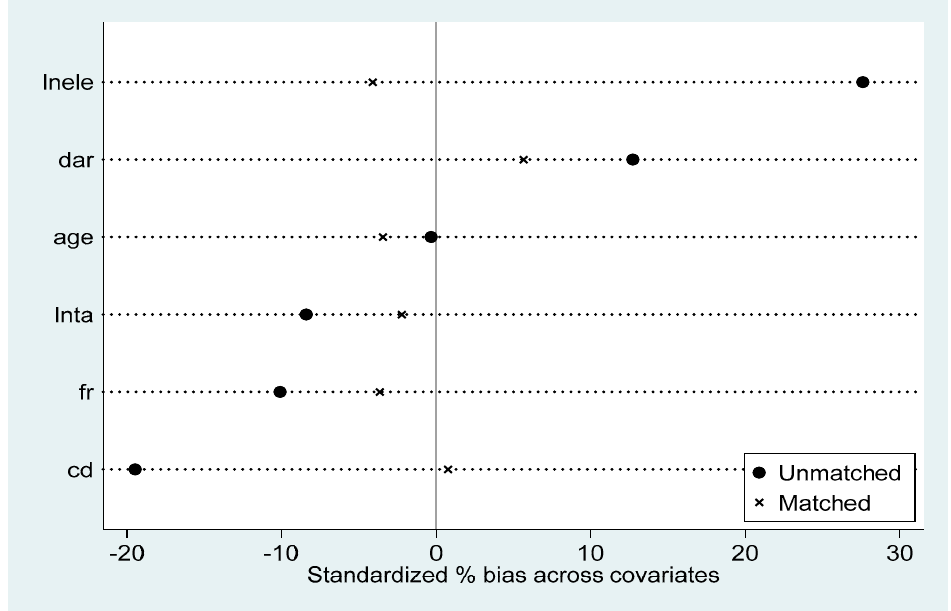
Table A1. Equilibrium test of covariates before and after matching.